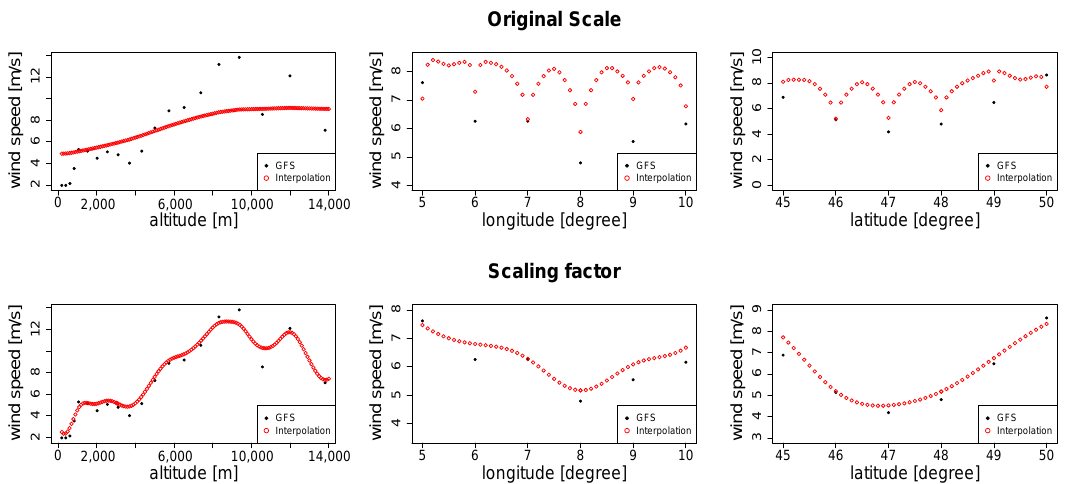
Figure 13. In-sample interpolation of wind speed with Ordinary Kriging demonstrates the necessity of the scaling factor. Data are from GFS analysis data on 3 November 2018, with longitude ranges from 5E to 10E and latitude from 45N to 50N.